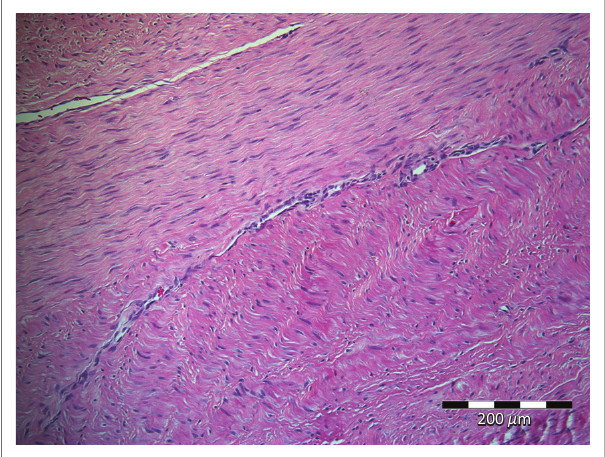
FIGURE 2: A photomicrograph showing the fibroma exhibiting interweaving regions of fairly well-differentiated but monotonous collagenous tissue. (H&E ×